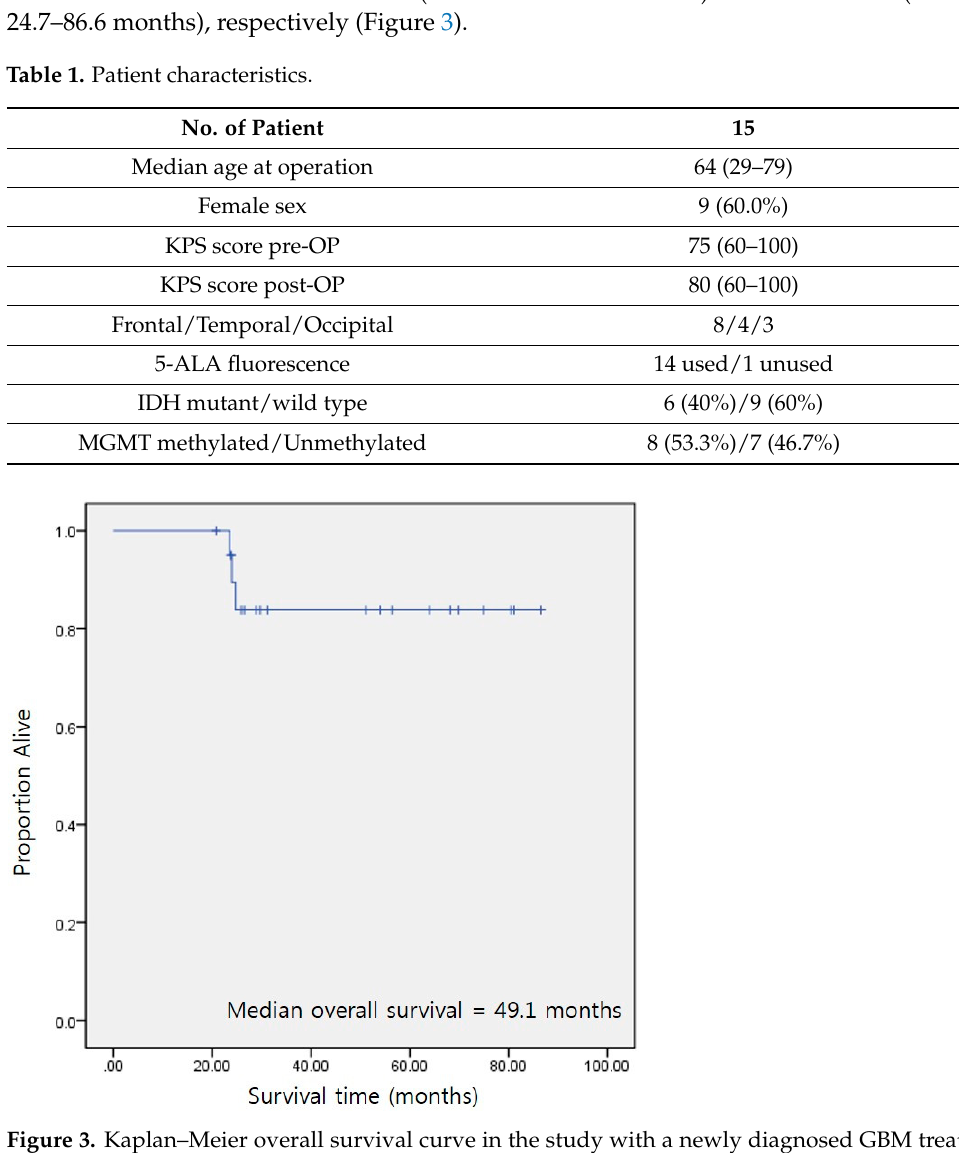
Figure 3. Kaplan–Meier overall survival curve in the study with a newly diagnosed GBM treated with SupTR (GTR with lobectomy). Table 1. Patient characteristics.